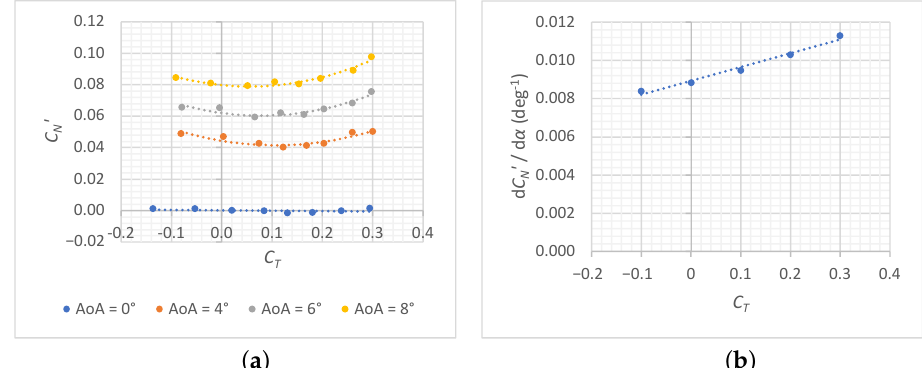
Figure 13. Evaluation of propeller in-plane forces with thrust and angle of attack: ( a ) alternative definition of the normal force coefficient with Equation (7); ( b ) combined effect of angle of attack and thrust